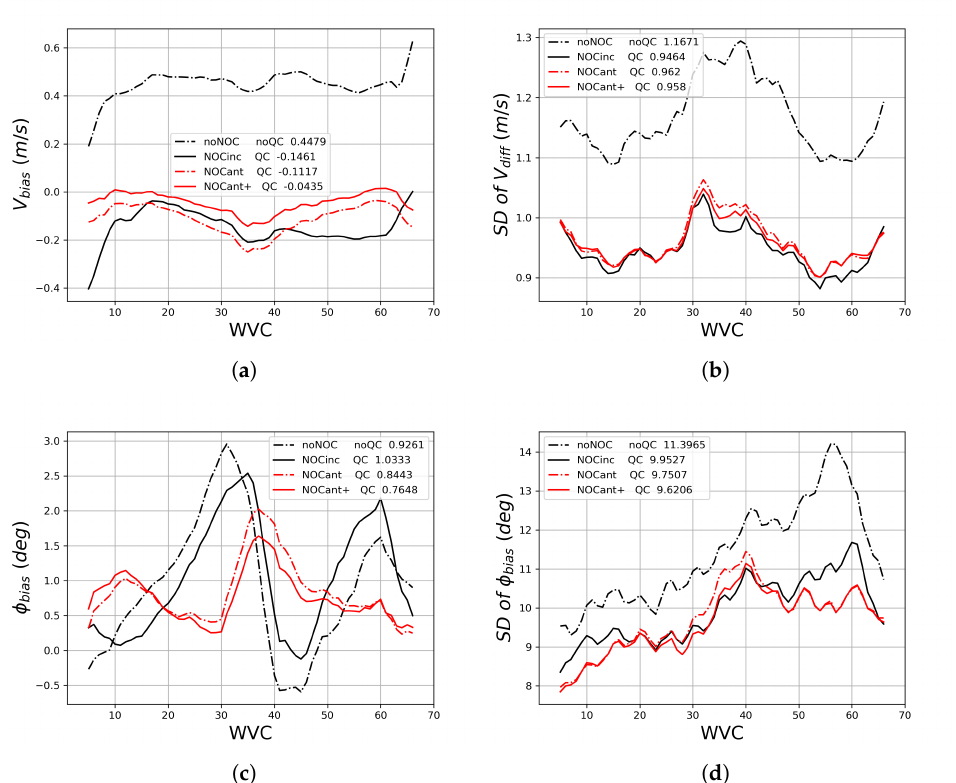
Figure 15. Ku-band ascending orbits wind retrieval statistics as a function of WVC with noNOC, NOCinc, NOCant, NOCant+. SST correction and QC are applied, and the mean numbers of each condition are stated beside each legend, data from 1 November 2022–3 November 2022: ( a ) wind speed bias, ( b ) wind speed SDD, ( c ) wind direction bias, ( d ) wind direction